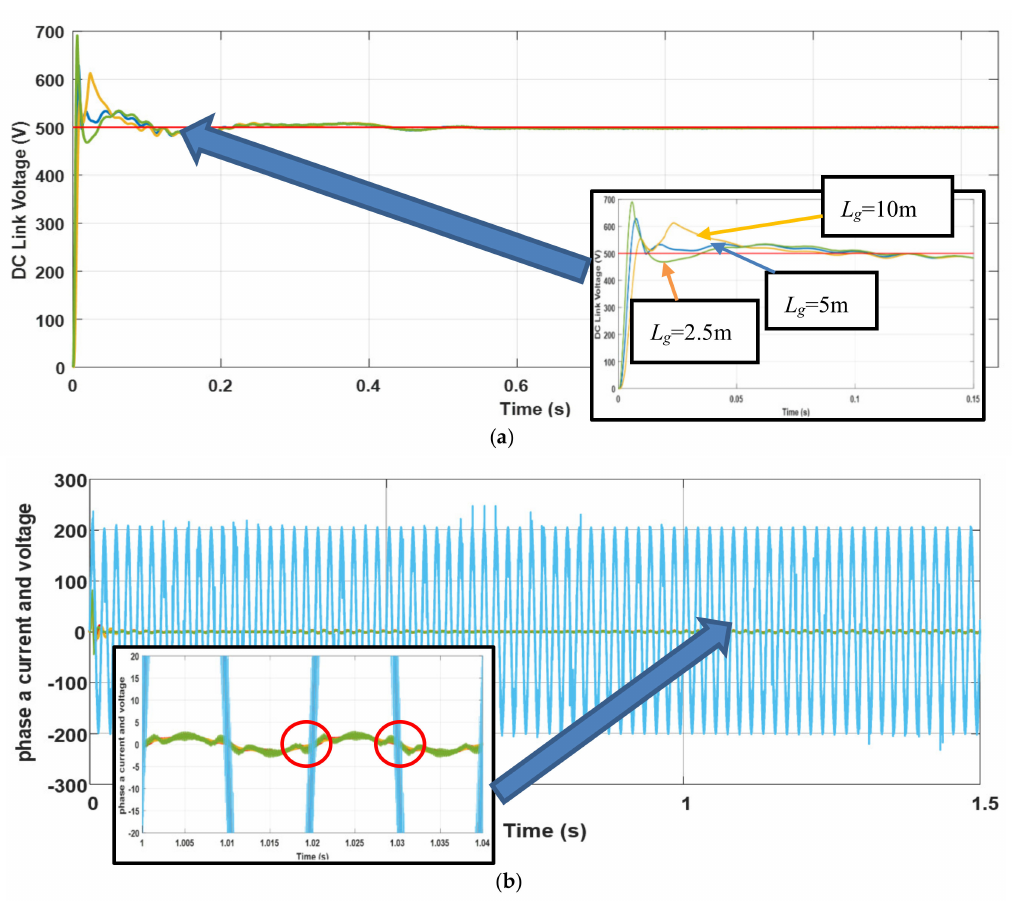
Figure A4. GSC waveforms at varying grid filter inductance: ( a ) DC-link voltage, ( b ) grid